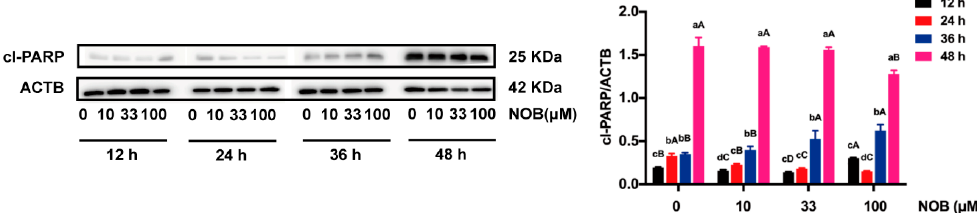
Figure 6. The effect of NOB on cleaved PARP (cl-PARP) of BeWo cells. The expression of cl-PARP Figure 6. The e ff ect of NOB on cleaved PARP (cl-PARP) of BeWo cells. The expression of cl-PARP was measured by Western blot. Data were summarized as mean ± SD, n = three independent